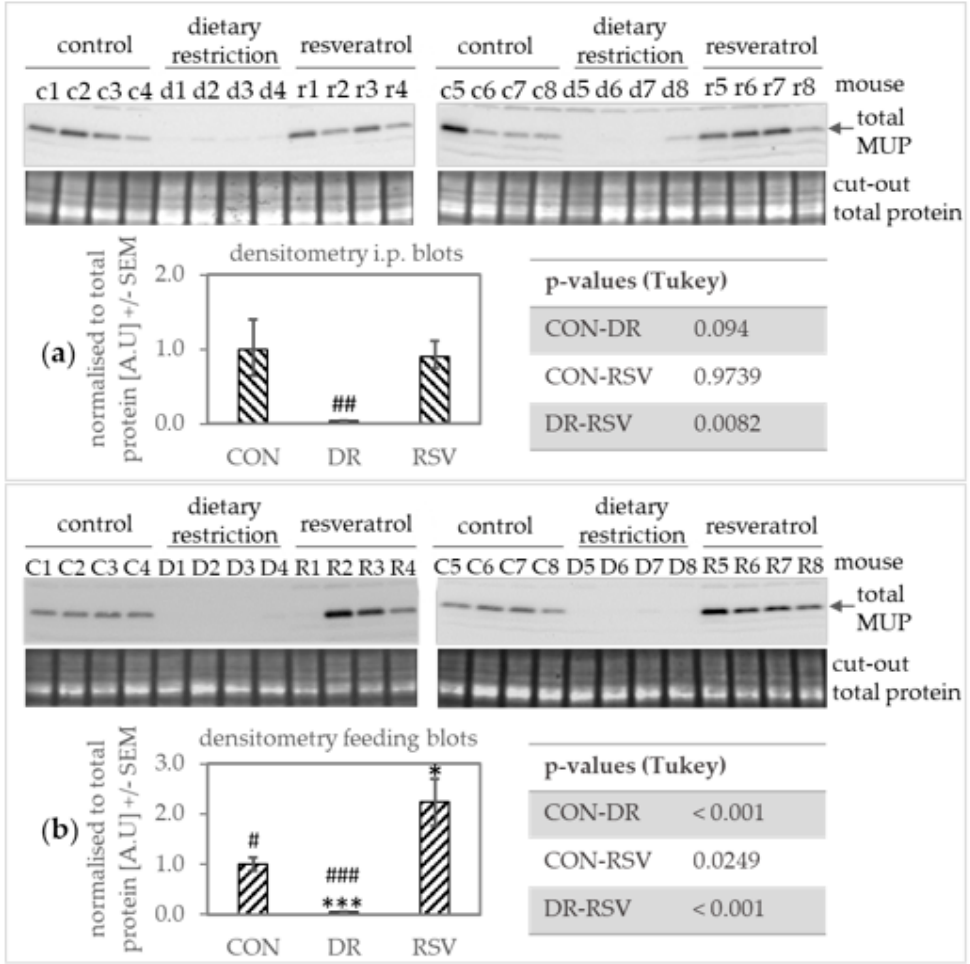
Figure 1. Western blots showing mouse urinary protein (MUP) levels in livers of mice supplemented with resveratrol (RSV) compared to ad-libitum control mice (CON) and mice under dietary restriction (DR). ( a ) RSV was injected intraperitoneally, ( b ) RSV was supplemented via diet. MUP levels fall drastically upon dietary restriction but not so by RSV application. Liver lysates from 12 different mice per blot were run, with two blots per experiment this is n = 8 mice per group. Mice from the i.p trial were named with a lower key letter (c—AL control; d—dietary restriction, r—resveratrol), animals from the feeding trial were named with the corresponding upper key letter (C—AL control, D—dietary restriction, R—resveratrol). The number refers to the number given the animal in the trial. Data is presented as mean +/ − SEM. * p < 0.05, *** p < 0.001 compared to CON; # p < 0.05, ## p < 0.01, ### p < 0.001 compared to RSV (Tukey).